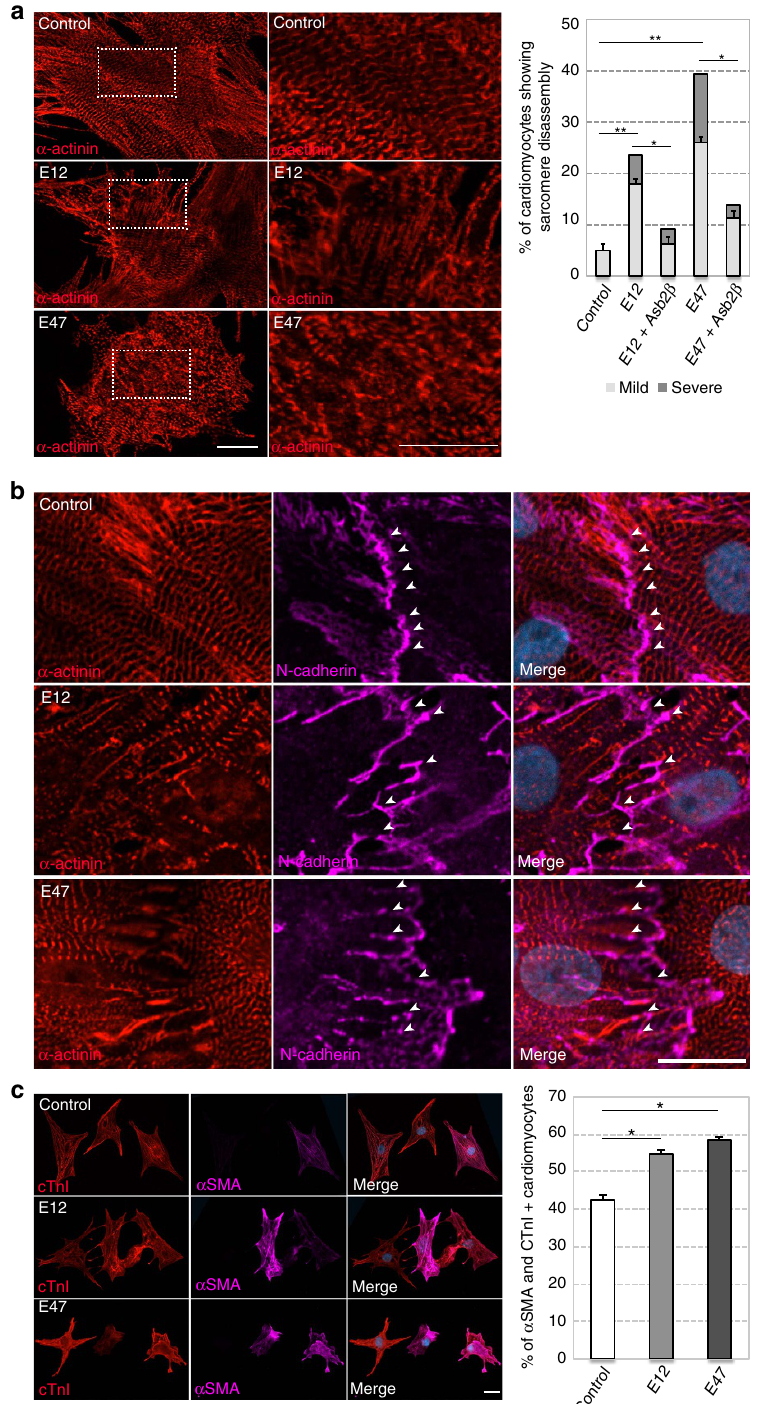
Figure 5 | TCF3 causes dedifferentiation of rat NCMs. ( a ) Rat NCMs transfected with control, E12 or E47 adenovirus vectors, stained for sarcomeric- a - actinin (red). Magnified views in white dotted boxes are shown on the right. Number of cardiomyocytes transfected with adenovirus vectors exhibiting sarcomere disassembly ( n ¼ 2, with averages taken from 50 cardiomyocytes). ( b ) Rat NCMs transfected with control, E12 or E47 adenovirus vector, co-stained for a -actinin (red), N-cadherin (magenta) and 4,6-diamidino-2-phenylindole (DAPI; blue). Cardiomyocytes expressing E12 and E47 exhibit disruptions of cell–cell junction (arrowheads). ( c ) Rat NCMs transfected with control, E12 or E47 adenovirus vector, co-stained for cardiac troponin I (cTnI, red), a -smooth muscle actin ( a -SMA, magenta) and DAPI (blue). Number of cardiomyocytes transfected with adenovirus vectors exhibiting both cTnI and a -SMA expression ( n ¼ 2, with averages taken from 50 cells). * P o 0.05 and ** P o 0.01 by one-way analysis of variance (ANOVA) followed by Tukey’s honest significant difference test. Error bars, s.e.m. Scale bars, 20 m